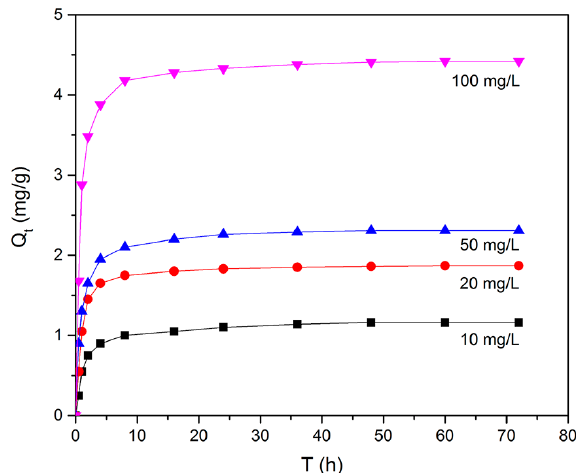
Figure 9. Effect of initial concentration and contact time on removal efficiency (experimental conditions: adsorbent dose = 7.0 g/L, initial concentration = 10–100 mg/L, pH = 6, T = 30 °C). adsorbent dose = 7.0 g / L, initial concentration = 10–100 mg / L, pH = 6, T = 30 ◦